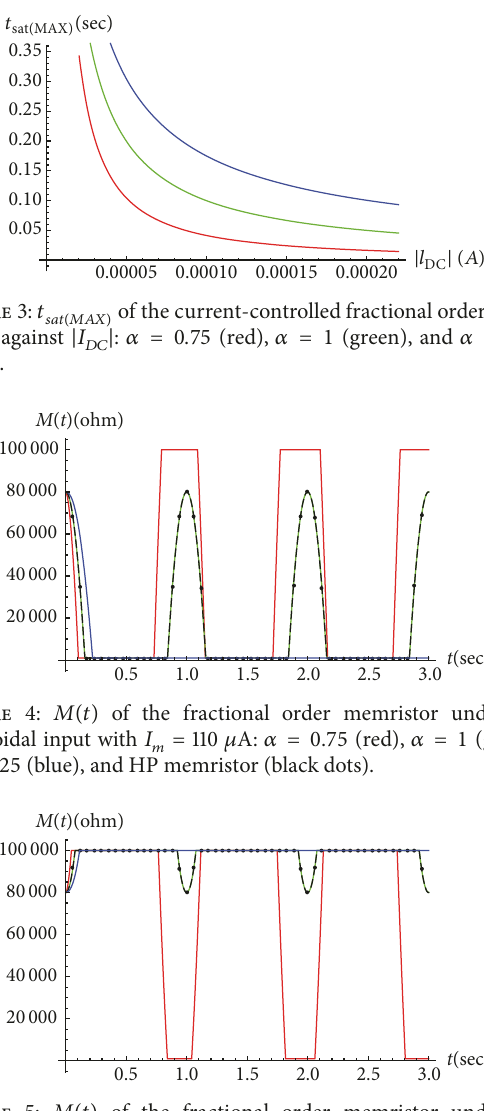
Figure 5: 𝑀(𝑡) of the fractional order memristor under the sinusoidal input with 𝐼 𝑚 = -110 𝜇 A: 𝛼 = 0.75 (red), 𝛼 = 1 (green), 𝛼 = 1.25 (blue), and HP memristor (black dots).